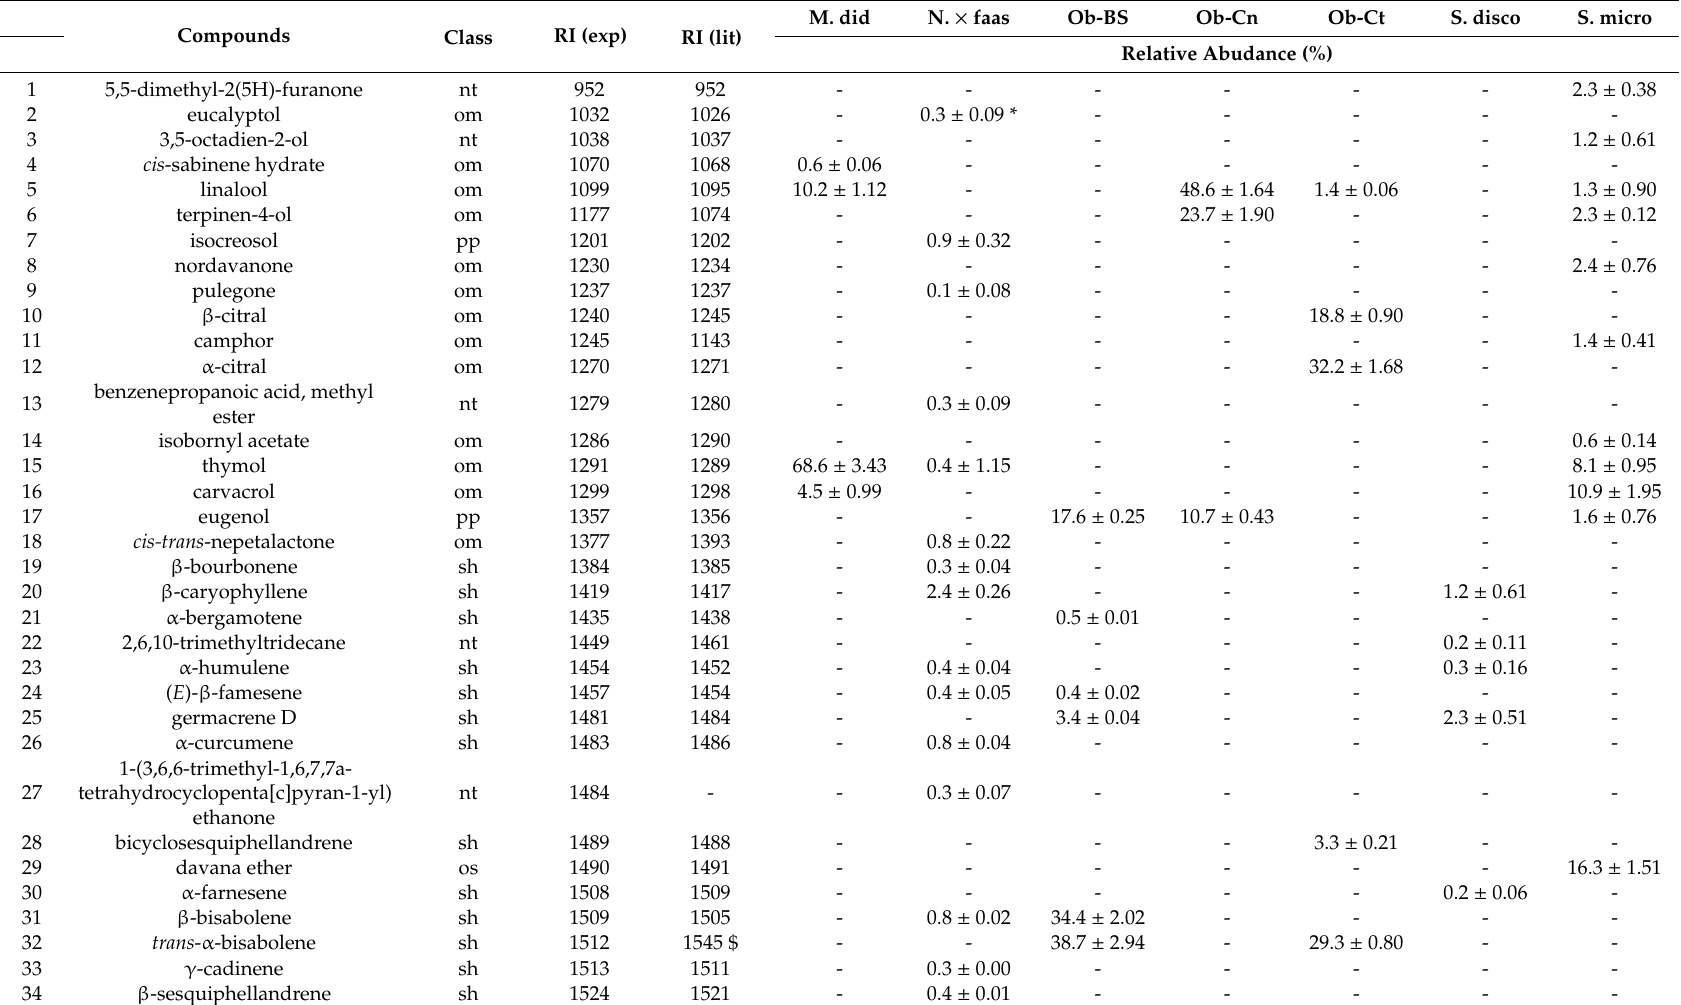
Table 4. Chemical composition of the flower EOs from the studied Lamiaceae species (n = 3) 1